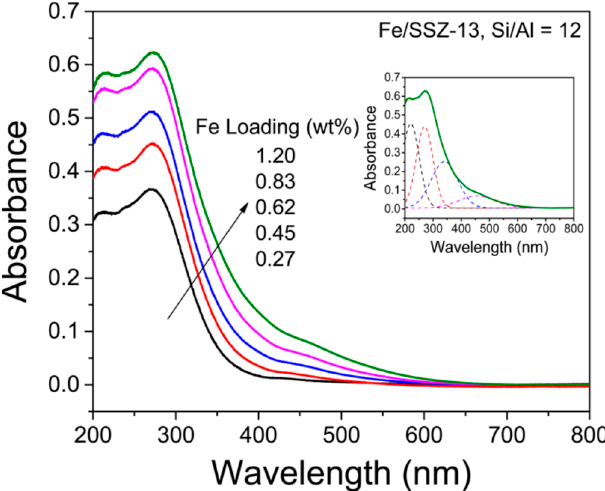
Figure 1. UV-vis spectra of the fresh, ambient Fe/SSZ-13 samples with different Fe loadings (loadings are marked adjacent to the spectra). The inset shows the peak fitting results of the Fe loading 1.20% sample. Reprinted with permission from [28]. Copyright © 2016 American Chemical Society.